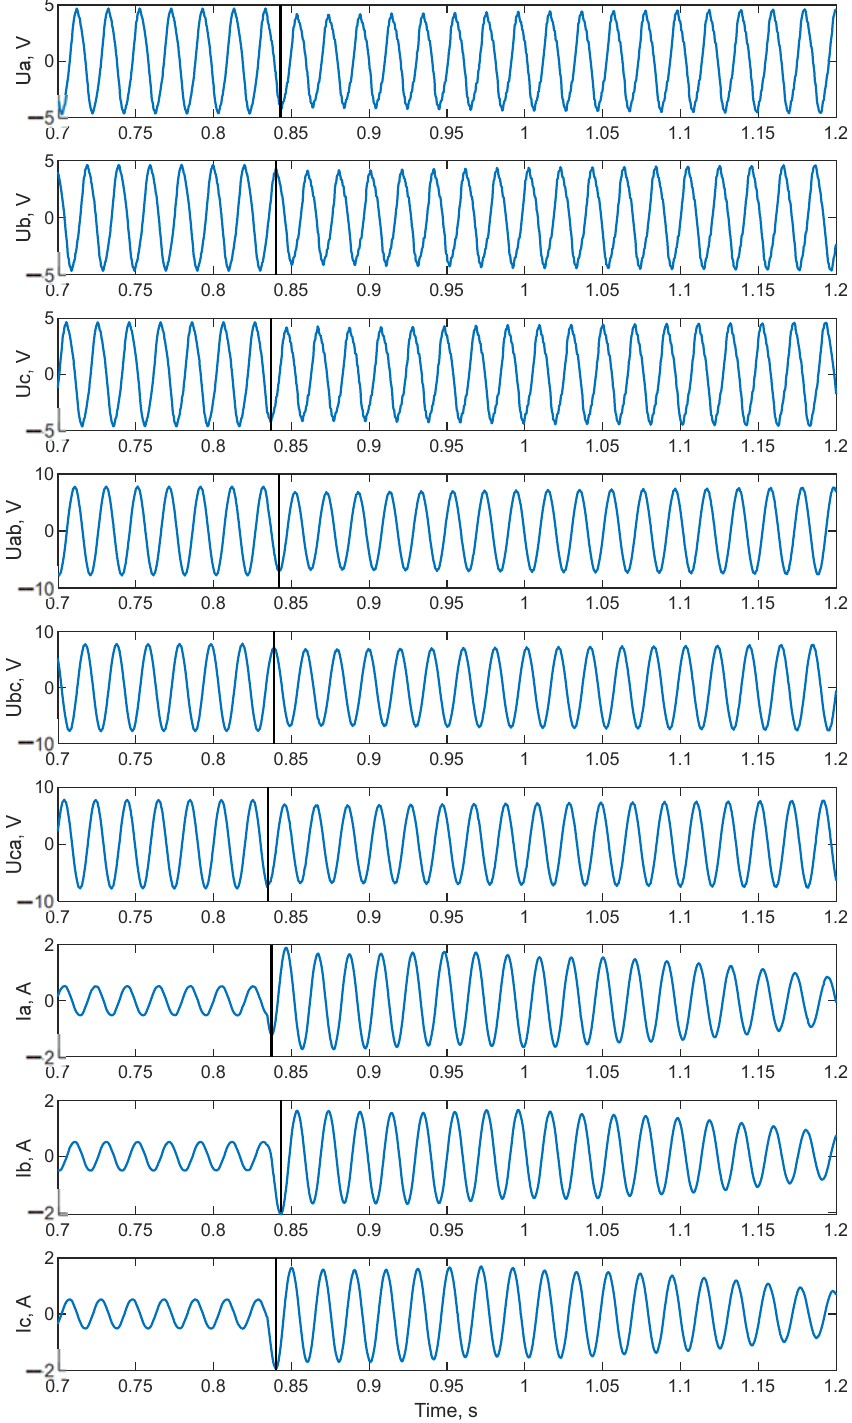
Figure 10. Results of accuracy improvement for algorithm 1. Table 5. Comparison of the results for algorithm 1 after accuracy improvement.